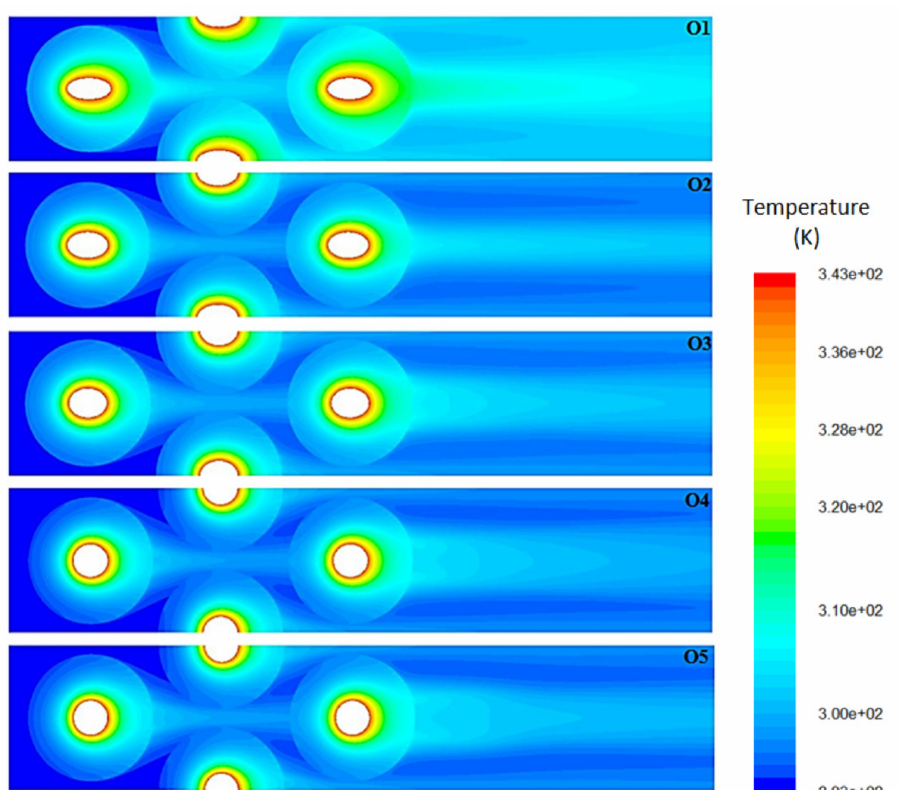
Figure 6. Temperature contours in the middle of the fin thickness for all the geometries of the oval tube.